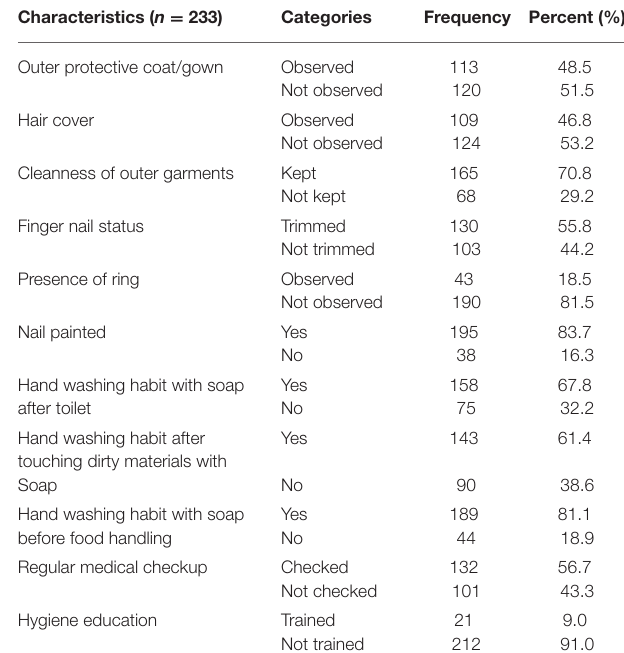
TABLE 2 | Personal hygiene practices of food handlers worked in the students’ caterings of WSU, Wolaita Sodo, South Ethiopia from January 10 to February 10,